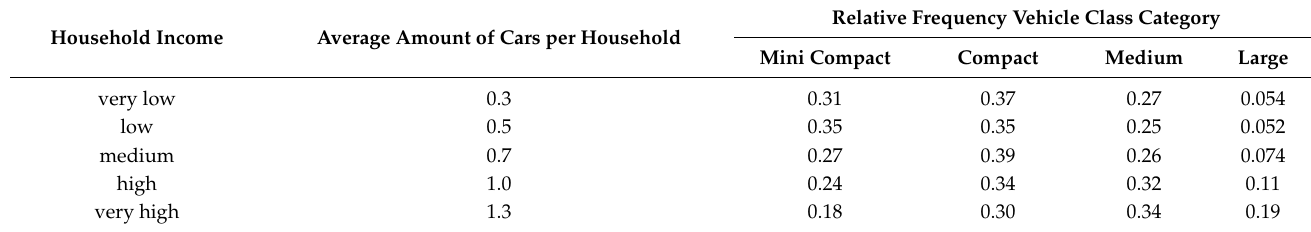
Table 1. Correlation between household income and vehicles in